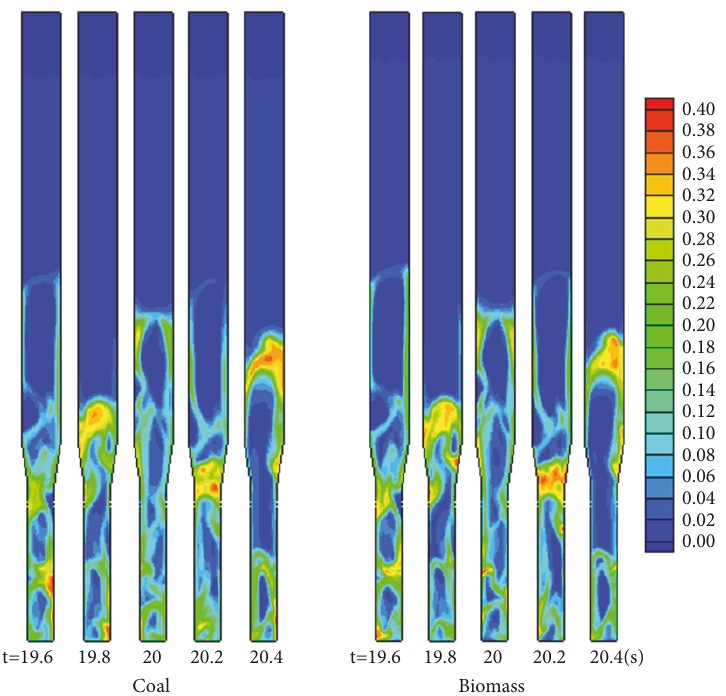
Figure 4: The instantaneous volume fraction of coal and biomass.